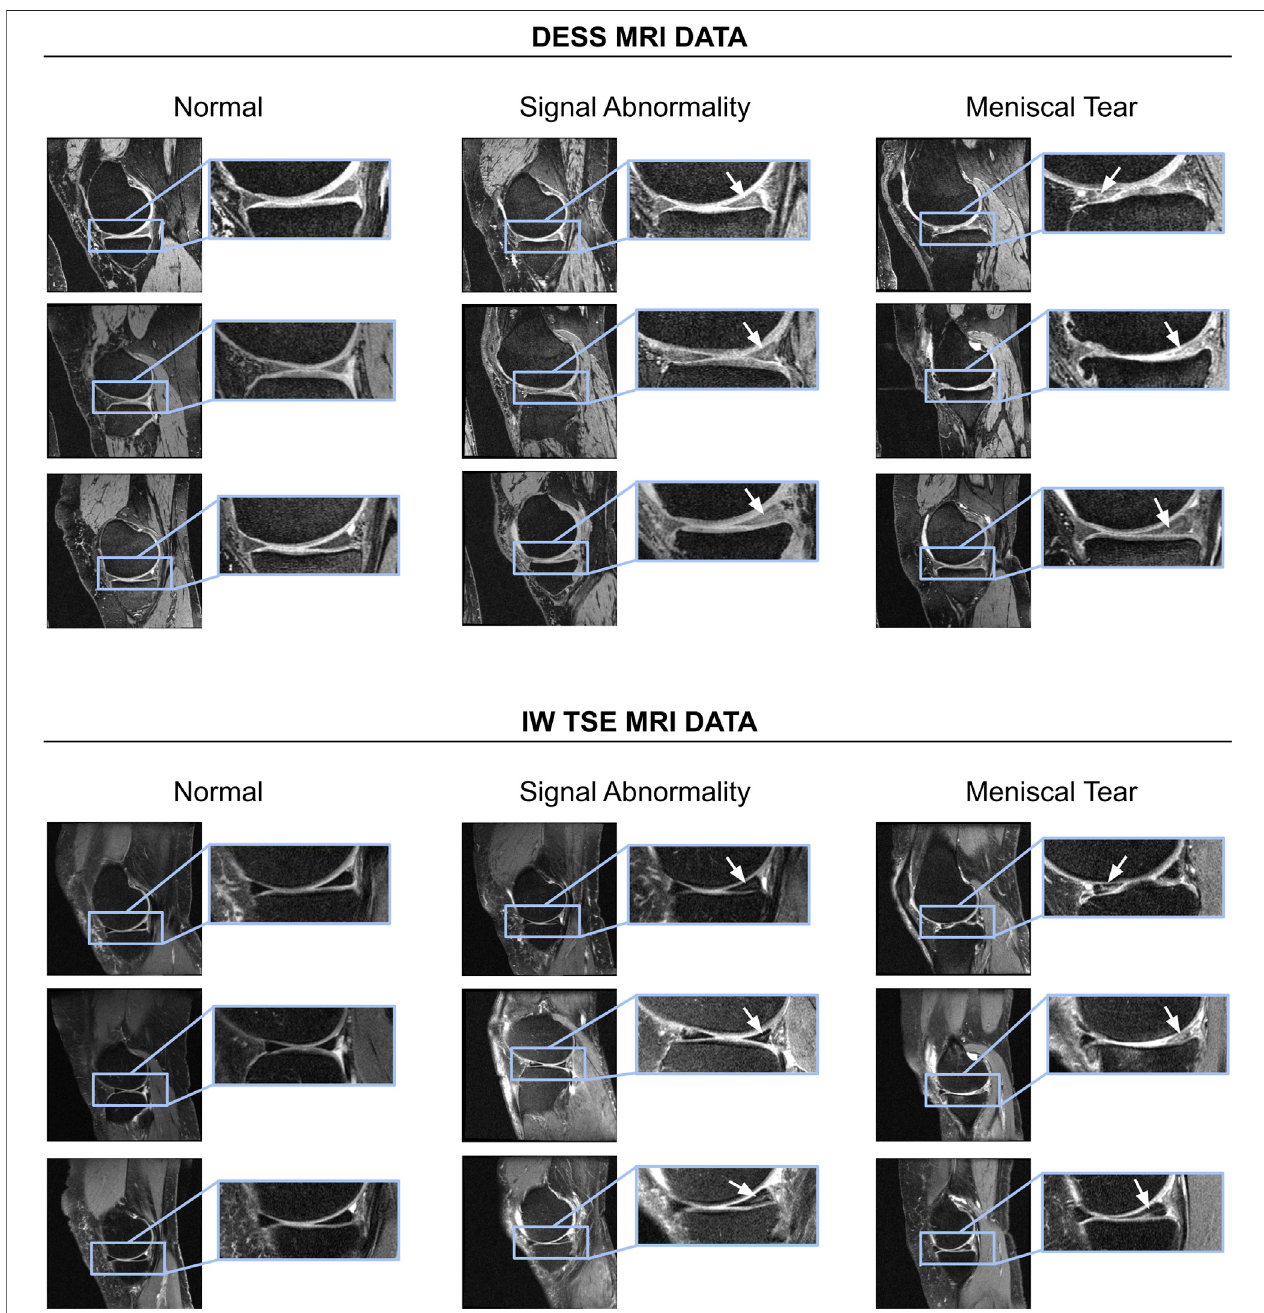
FIGURE 1 | Examples of normal menisci, signal abnormalities, and subjects with meniscal tears shown for DESS as well as IW TSE MRI data. For a summary of different types of meniscal tears per sub-region the reader is referred to Supplementary Table S1 .